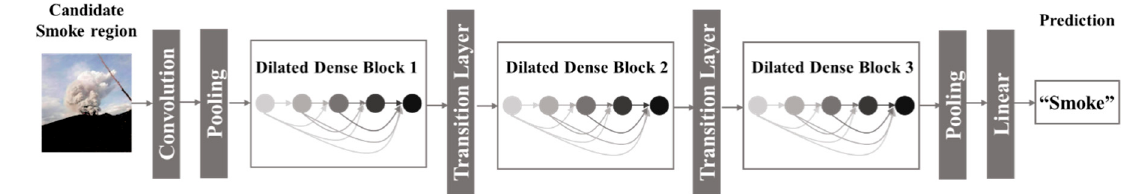
Figure 2 . Network architecture of proposed wildfire smoke dilated DenseNet (WSDD-Net).